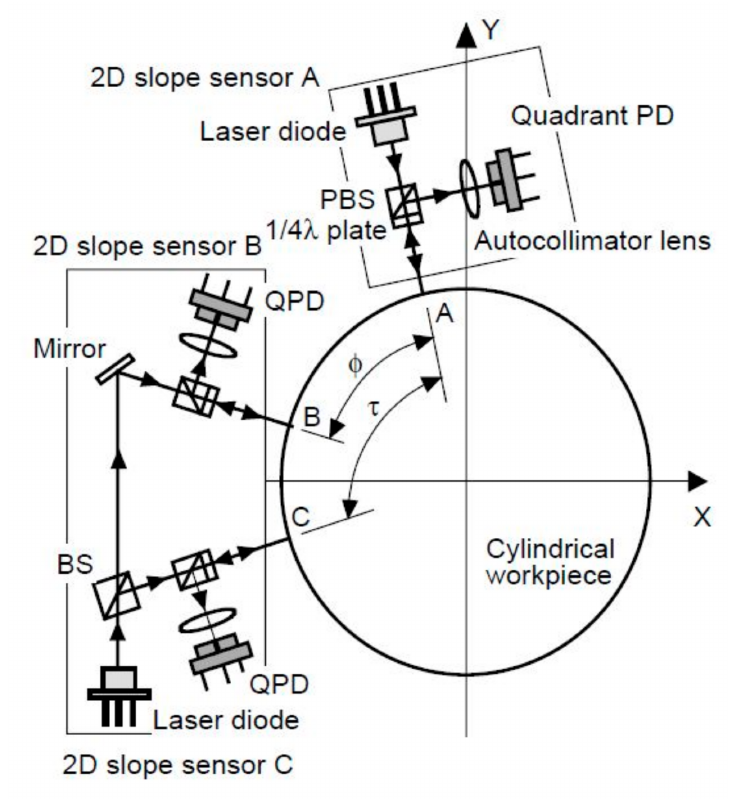
Figure 22. Biaxial slope sensors